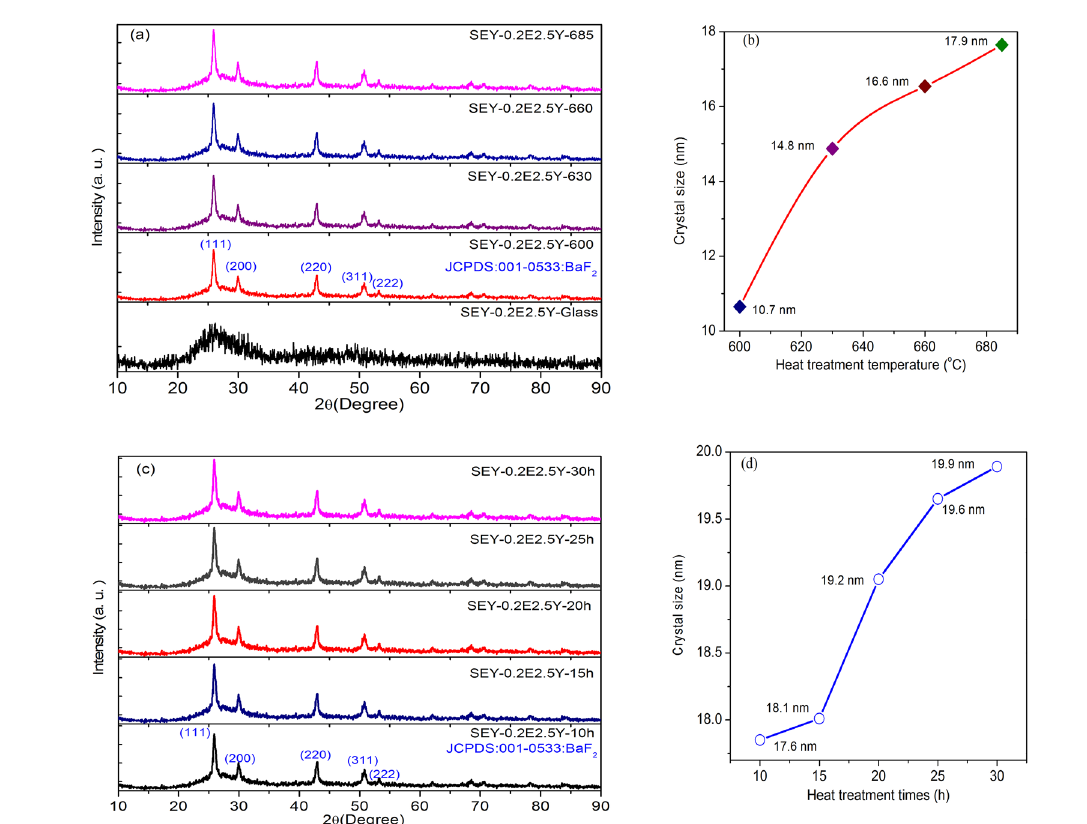
Figure 2. (a) XRD patterns of SEY-0.2E2.5Y glass sample and SEY-0.2E2.5Y-600, SEY-0.2E2.5Y-630, SEY-0.2E2.5Y-660 and SEY- 0.2E2.5Y-685 transparent glass-ceramics samples; (b) Relationship between crystal size with the heat treatment temperatures; (c) XRD patterns of the SEY-0.2E2.5Y-10h, SEY-0.2E2.5Y-15h, SEY-0.2E2.5Y-20h, SEY-0.2E2.5Y-25h and SEY-0.2E2.5Y-30h transparent glass-ceramics samples; (d) Relationship between crystal size with the heat treatment